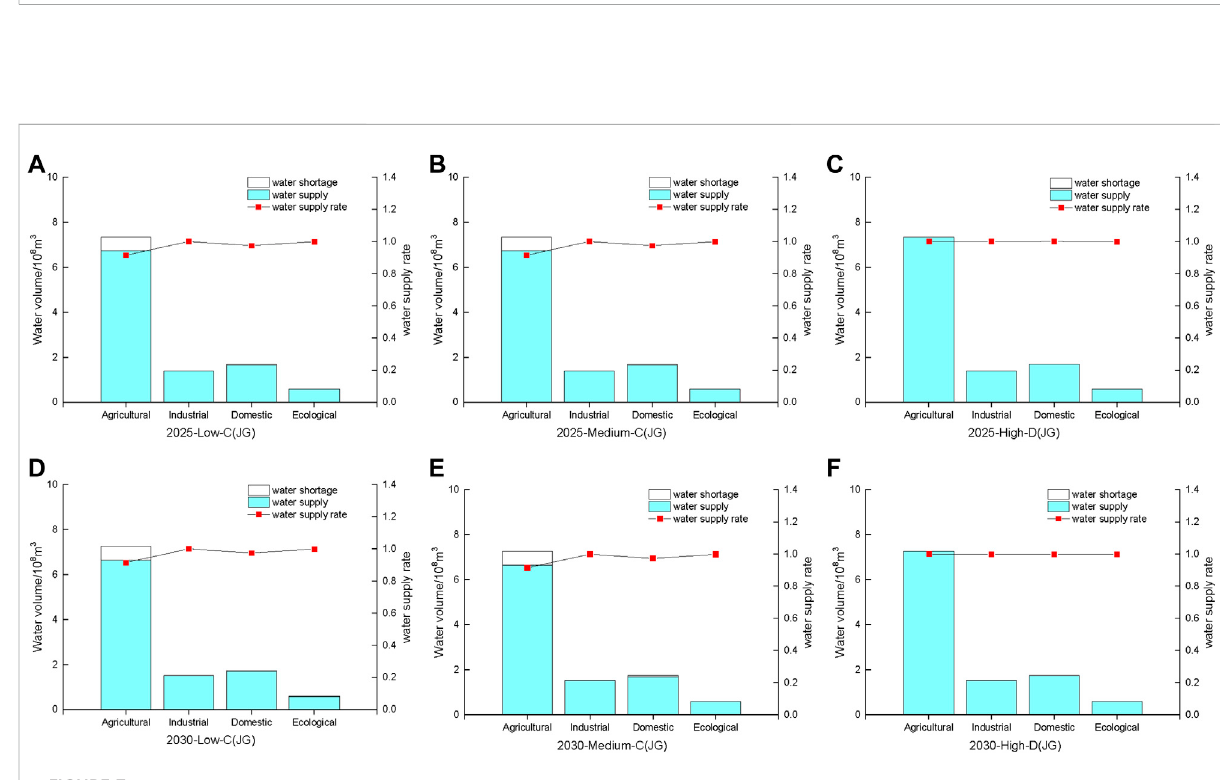
FIGURE 7 Distribution of water resources for six suitable scenarios in Jiahetan-Gaocun section [ (A – F) represent 6 selected scenarios respectively].